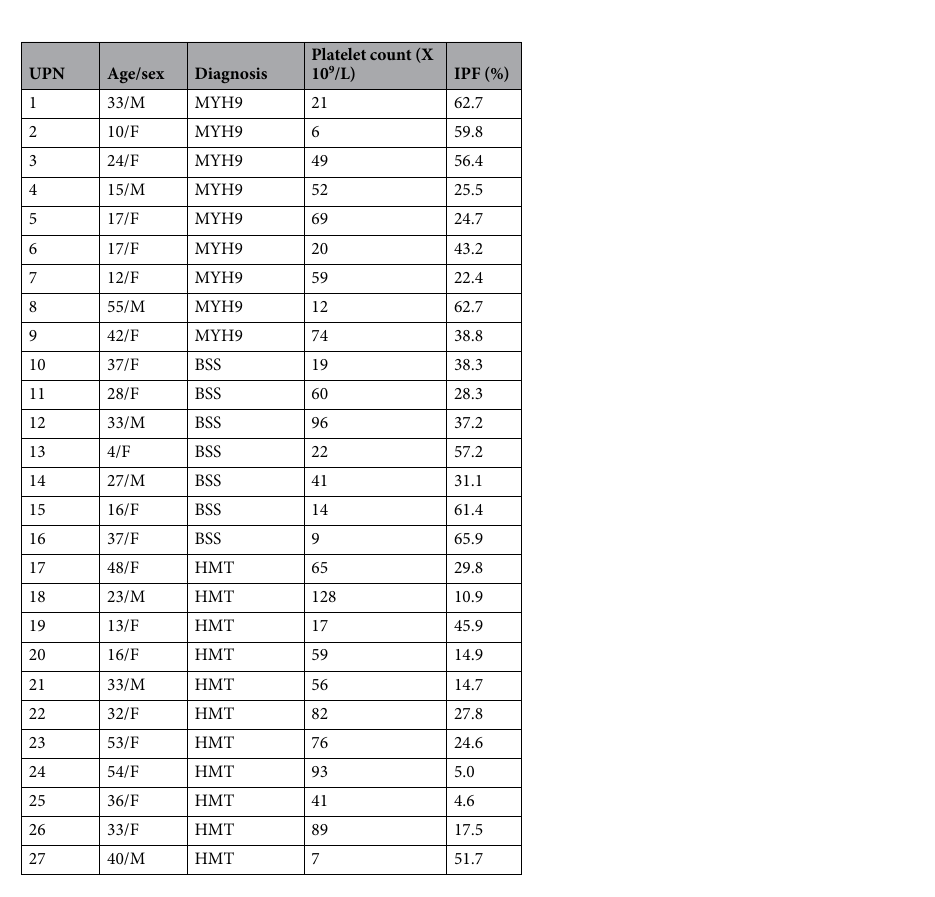
Table 2. Characteristics of patients with hereditary macrothrombocytopenia. UPN: unique patient number; MYH9: MYH9 -related platelet disorders; BSS: Bernard Soulier syndrome; HMT: non-specified